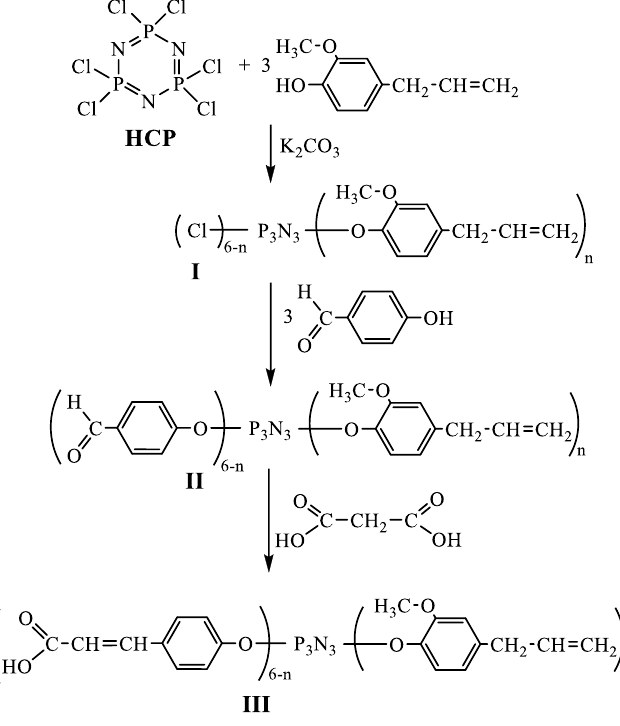
Figure 1. Synthetic scheme of cure site monomer preparation for the dental composition (I, II, III—products, the synthesis of which is indicated in the section "Materials and Methods").